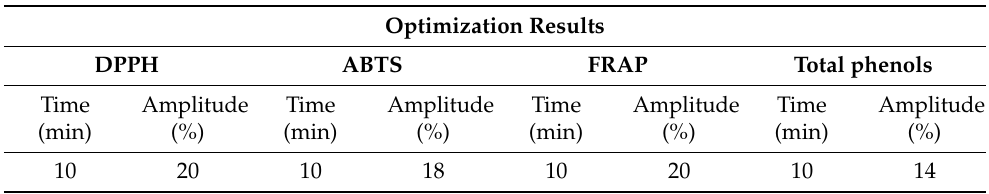
Table 4. Optimized conditions of high-power pulses on antioxidant capacity and phenolic content in sorghum lignin.